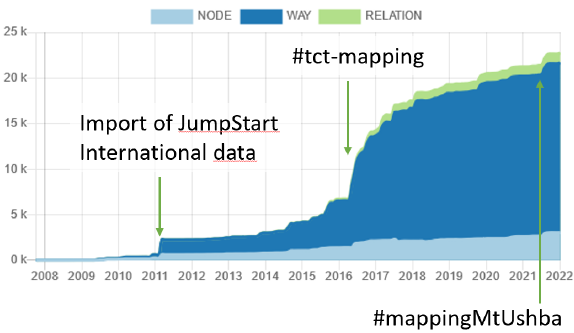
Figure 2. Contributions over the year to OpenStreetMap with marking for specific mapping campaigns, diagram created by the ohsome API (Raifer et al.,